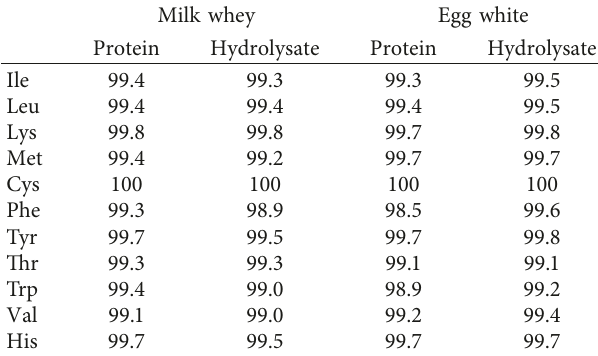
Figure 2: Digestibility (a) and net protein utilisation (b) of whey or egg white protein or hydrolysate. Data are mean ± SE of 6 rats. Different letters show significant difference at p < 0 . 05 by Tukey’s test. Table 4: Amino acid absorption (%) in the ileum of rats fed protein or hydrolysate of milk whey or egg white.